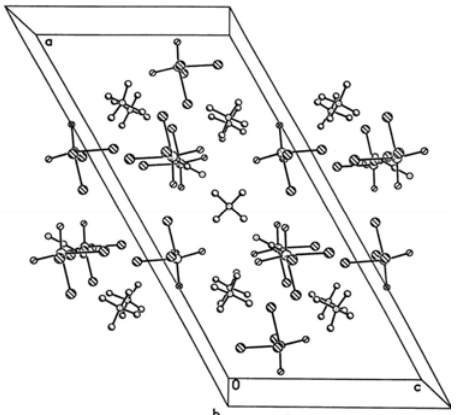
) N] [WOCl F][WO Cl ],CH CN Figure 2. Crystal packing of the [(CH 3 4 4 4 2 4 3 The trans W-Cl bonds to the oxygen atom [W(1)-Cl(1) = 2.583(2) , W(1)-Cl(3) = 2.564(2) and W(2)-Cl(6) = 2.563(2)] are longer than the cis W-Cl distances to oxygen atom [W(1)-Cl(2) = 2.3715(18) and W(2)-Cl(4) = 2.201(3) ] reflecting the greater trans influence of the oxygen atom as compared to the chlorine atom. The F atom in [WCl FO] is oriented cis to the oxo 4 ligands. The W-F bond length [W(2)-F(1) = 1.994(6)] is shorter than the sum of the single bond radi for W and the halides. The final atomic coordinates for the non-hydrogen atoms are given in Table 3 and selected bond lengths and angles are resumed in Table 4. Table 3. Selected bond length [Å].